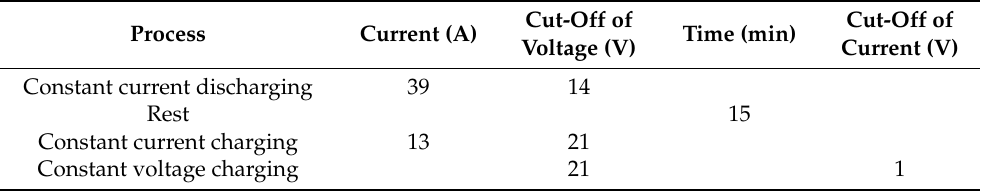
Table 3. Process of the charging and discharging.